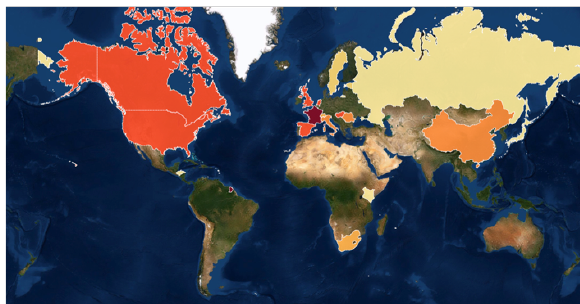
Figure 1. Interactive map showing the spatial distribution of the in-situ data available in LIMNADES (https://limnades.stir.ac.uk/Limnades_login/Statistics/Stats_boar d.php).